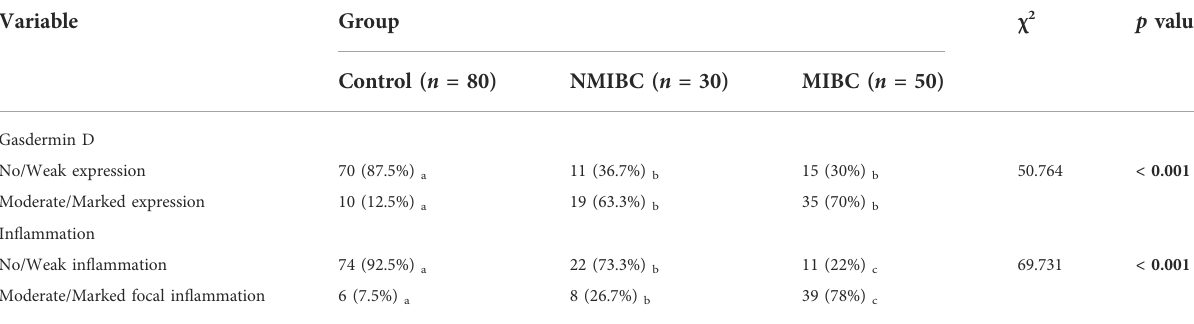
TABLE 6 Gasdermin D protein expression (by immunohistochemistry) in the bladder cancer tissue samples: